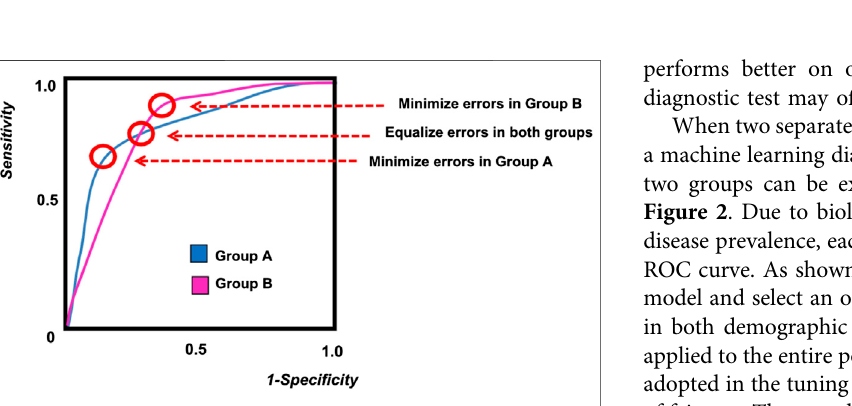
FIGURE1|(left) Illustrationshowing samplediagnostic test resultsforagiventhreshold; (right) SampleROCcurveshowinghowthesensitivityvariesfordifferent threshold values.